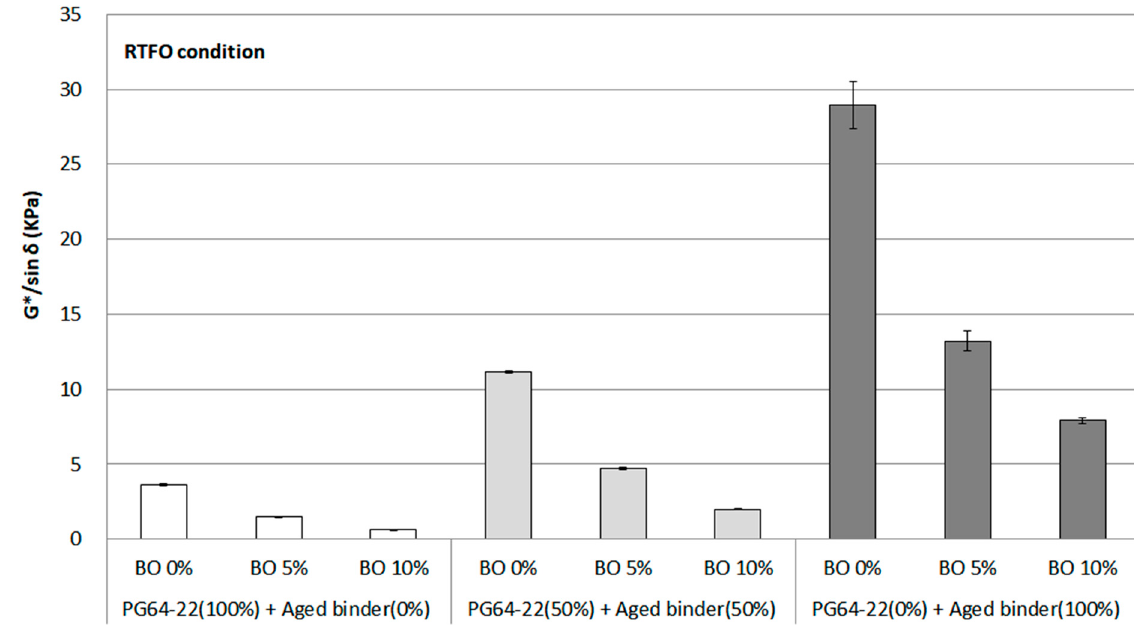
Figure 6. G*/sin δ of each asphalt binder containing the base oil for RTFO condition.